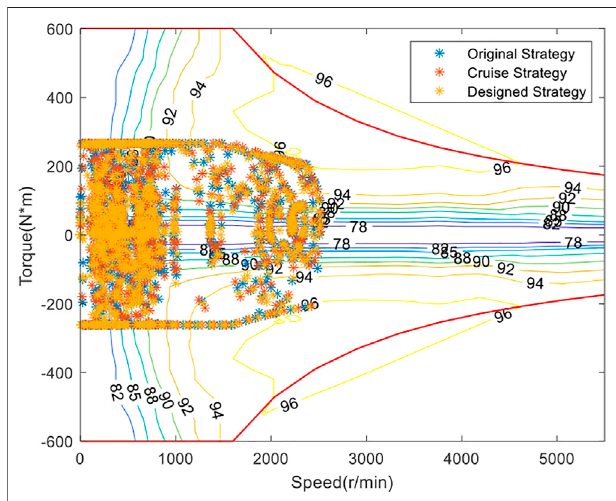
FIGURE 12 | Distribution of working ef fi ciency points of the drive motor.